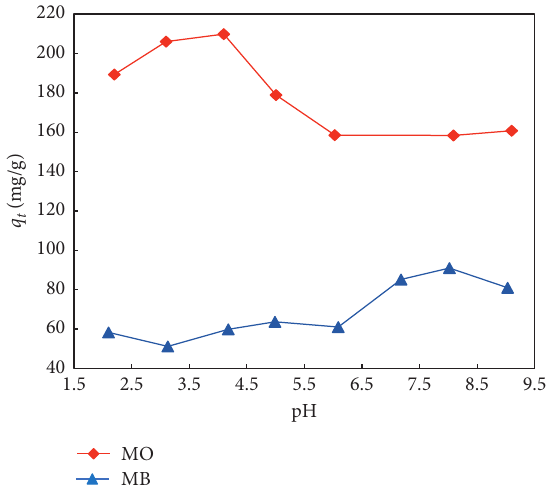
Figure 9: Influence of KCl on the adsorption of MB and MO by UiO-66-NO 2